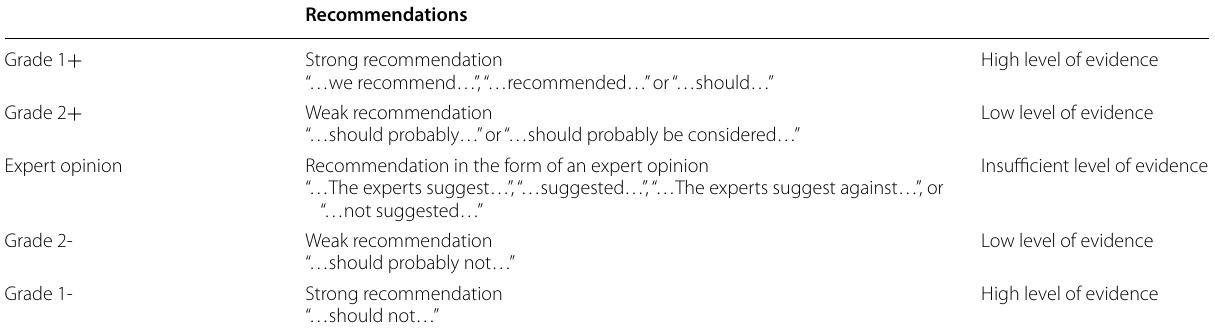
Table 3 Recommendations according to the GRADE